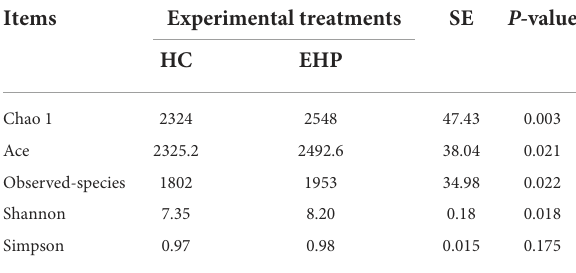
TABLE 4 Comparison of bacterial alpha diversity indices between the HC group and 0.60% EHP supplement ( n ,